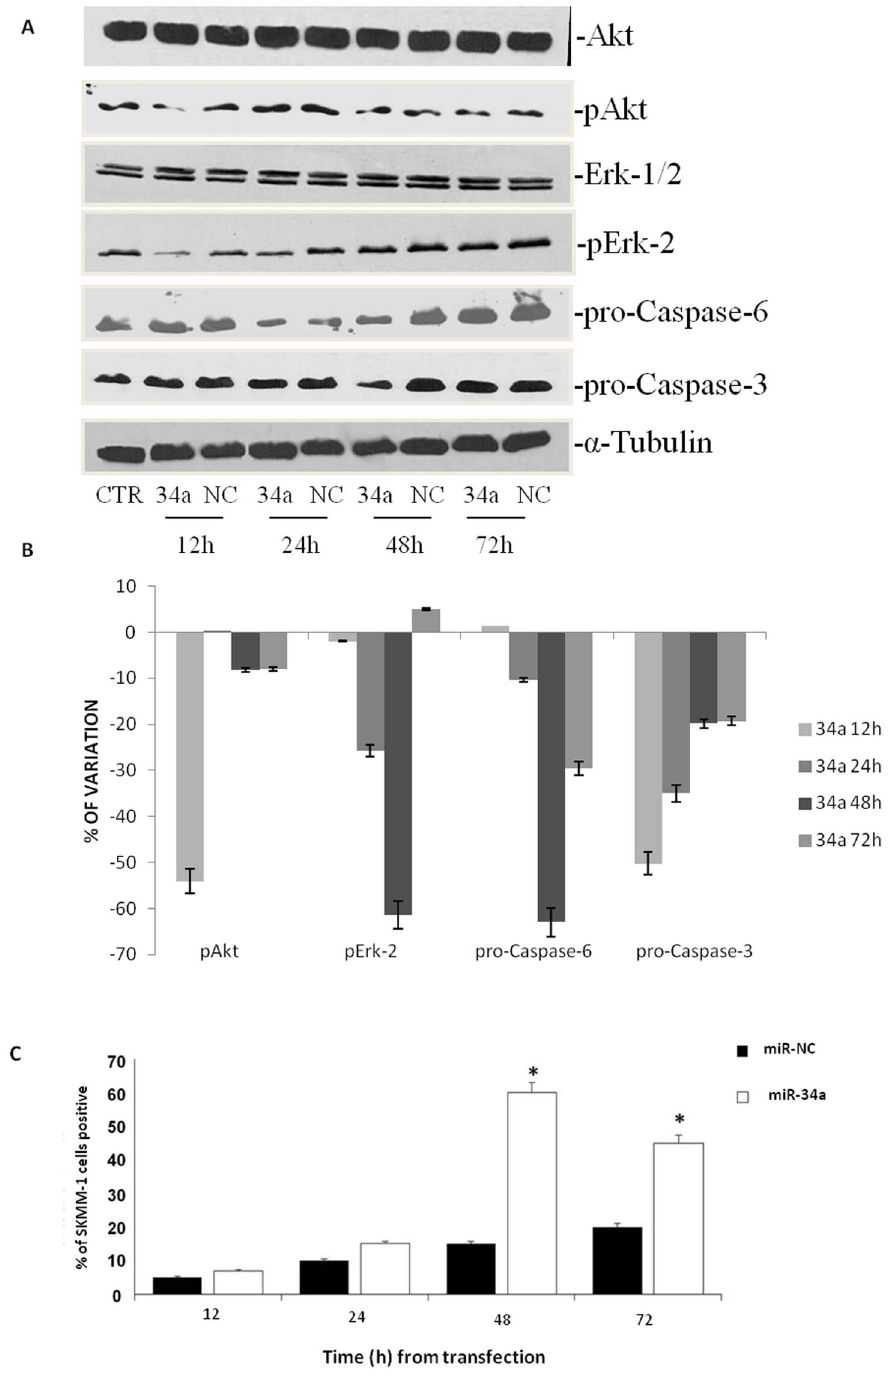
Figure 2. Effects of miR-34a replacement on survival pathways and apoptosis occurrence. A) SKMM-1 cells were transfected with miR-34a (34a) or scramble miR-NC (NC) and after different times from the transfection were collected for Western blot analysis. Thereafter, the expression and phosphorylation of Erk, the activity and expression of Akt and pro-caspase-6 and -3 expression were evaluated after blotting with specific antibodies, as described in ‘‘Material and Methods’’. The house-keeping protein a -tubulin was used as loading control. Each point is representative of 3 different evaluations performed in 3 different experiments. B) Scan of the bands associated with pErk-2 expression and Akt activity normalized for total Erk-2 or Akt expression, respectively, and of pro-caspase-3 and pro-caspase-6 expression, normalized with the housekeeping protein a -tubulin in SKMM-1 cells, was performed with ImageJ software. The intensities of the bands were expressed as % of changes based upon determination of arbitrary units (%, mean of three different experiments). Each point is the mean of 3 different evaluations performed in at least 3 different experiments. Bars, s.e.’s. C) SKMM-1 cells after transfection with miR-34a (34a) or scramble miR-NC (NC). The cells were collected after the indicated times from the transfection and apoptosis was evaluated with TUNEL assay by FACScan as described in ‘‘Materials and Methods’’. Results are shown as percentage of apoptotic cells. Data are the average ‘SD of 3 independent experiments.